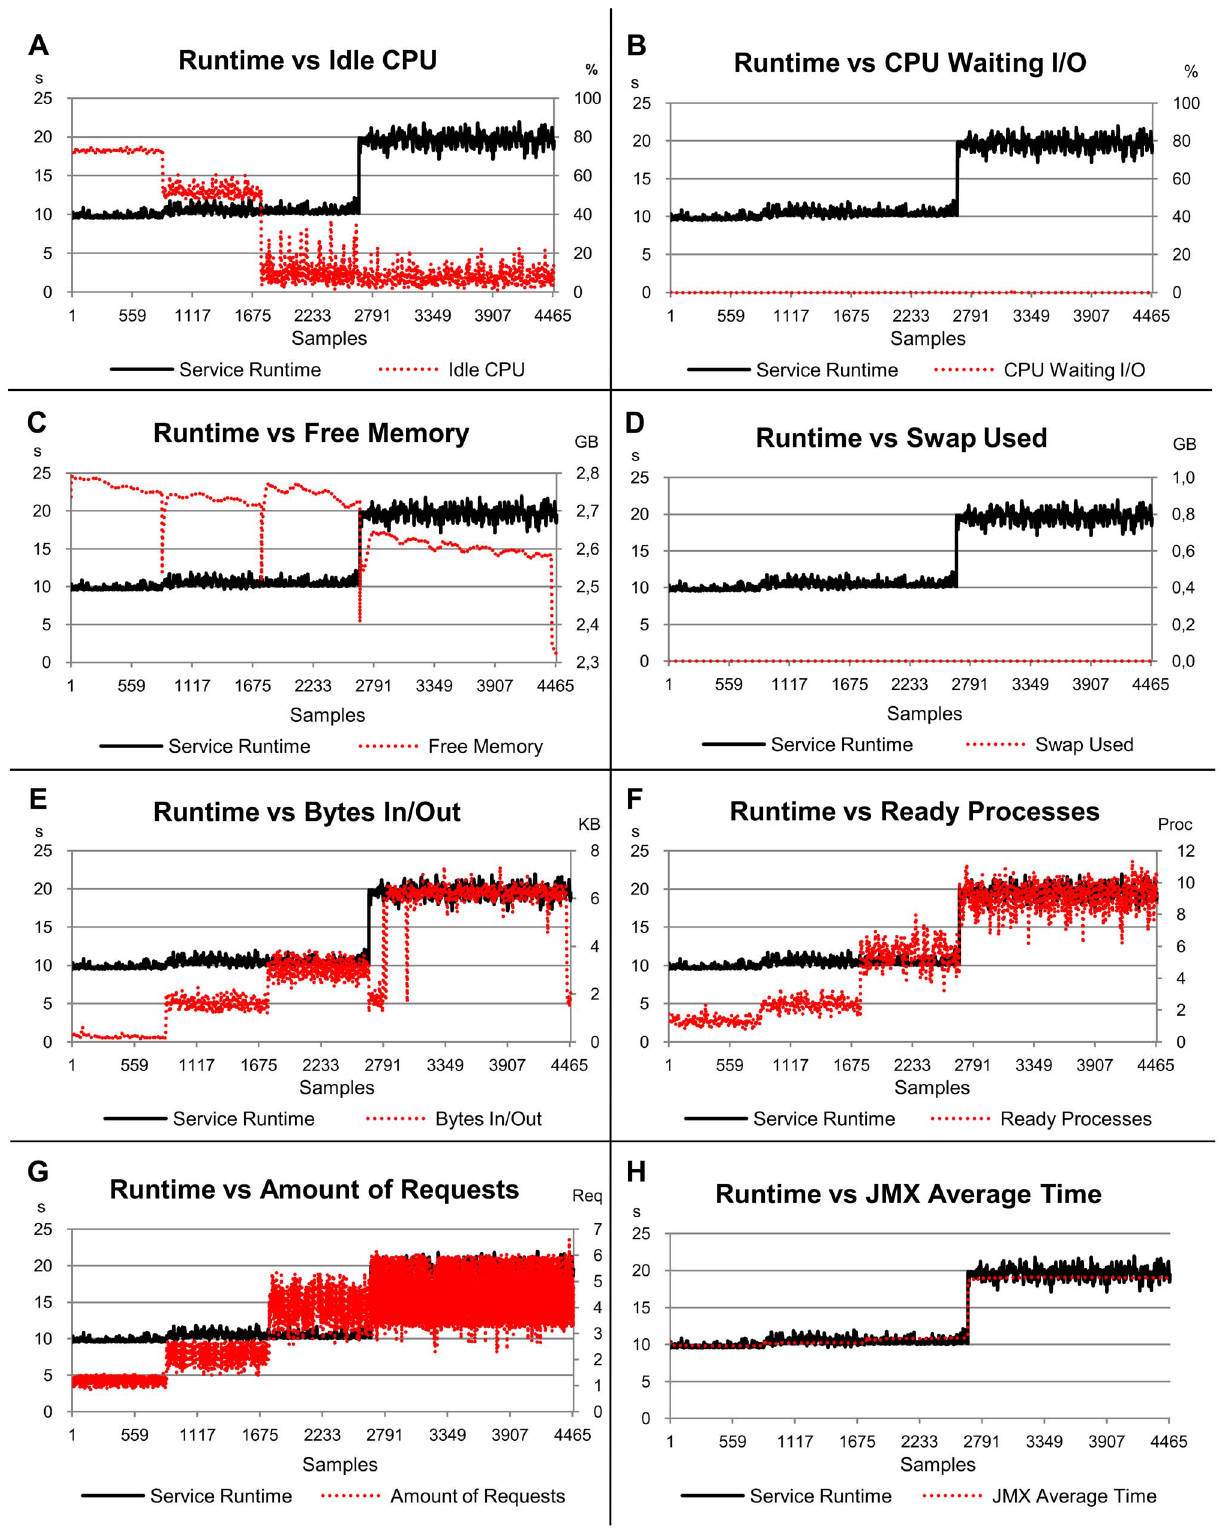
Figure 3. Relation of the service runtime versus eight load indices, considering the first scenario (CPU-bound service). The left-hand scale of the y-axis always represents the service runtimes in seconds (s). The right-hand scale of the y-axis, where necessary, represents the metric used by the load index. The x-axis represents the samples collected every 10 s by Ganglia and JMX while the benchmarks were requesting services for the server.